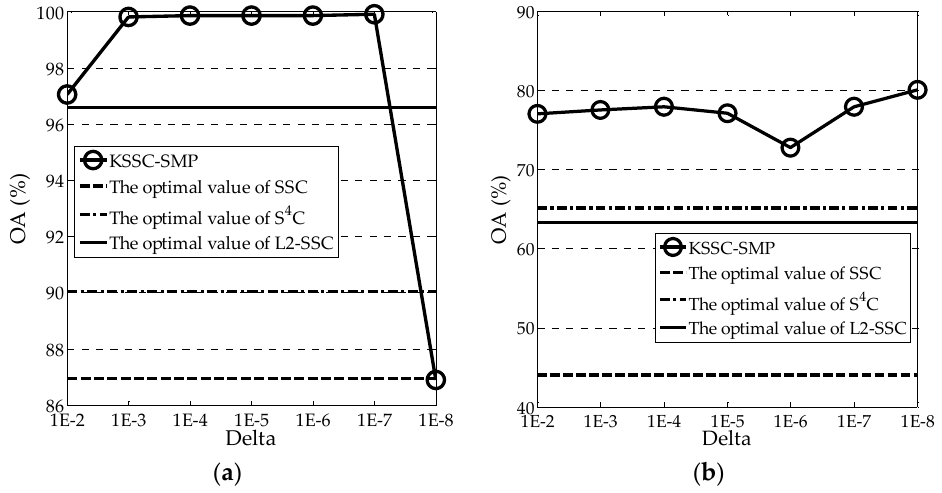
δ Figure 6. Analysis of parameter in the clustering performance for both image scenes. ( a ) Change Figure 6. Analysis of parameter δ in the clustering performance for both image scenes. ( a ) Change δ trend of OA versus for the Salinas image; ( b ) Change trend of OA versus trend of OA versus δ for the Salinas image; ( b ) Change trend of OA versus δ for the University of Pavia image. Pavia